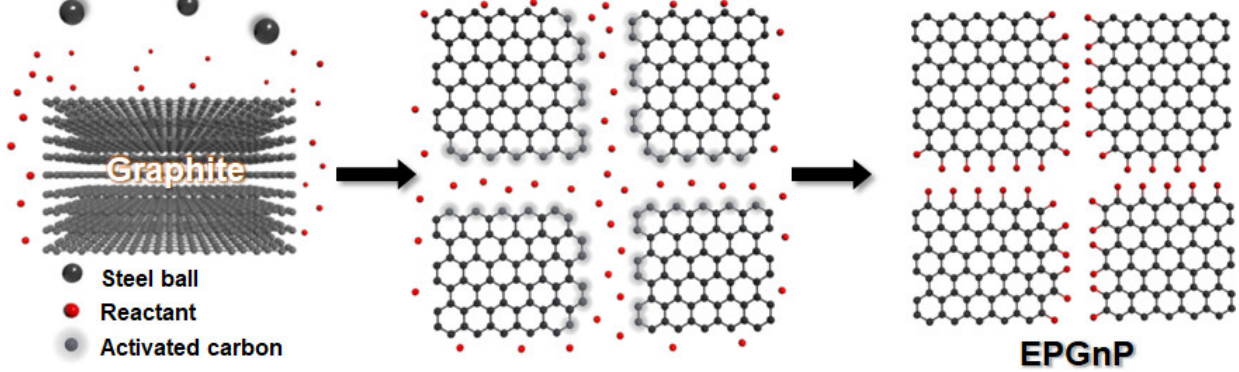
Figure 2. Conceptual diagram for preparation of EFGnPs by mechanochemical reaction.